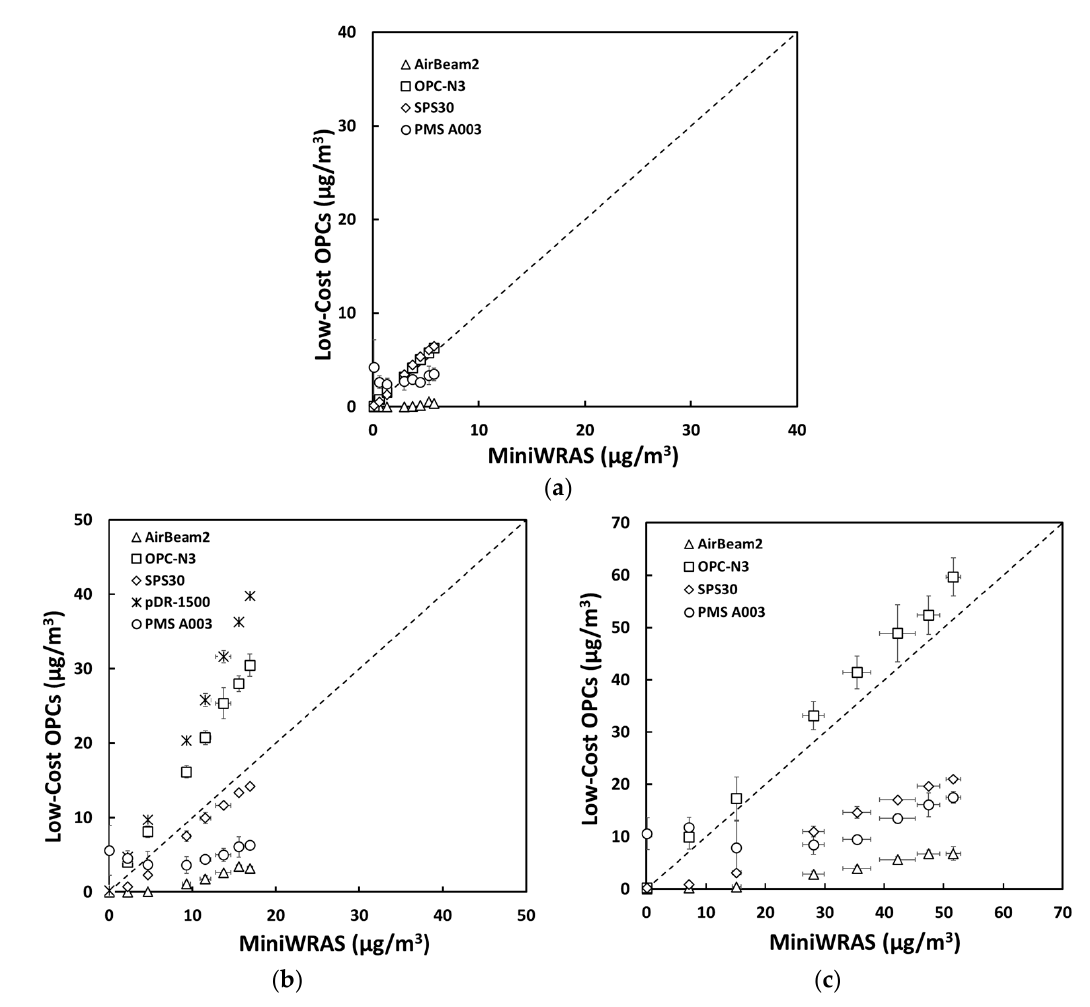
Figure 6. The mass concentrations (µg/m 3 ) of ( a ) PM 1 , ( b ) PM 2.5 mc, and ( c ) PM 10 reported by the sensors plotted against the reference device for the PAO-4 oil environmental experiment.